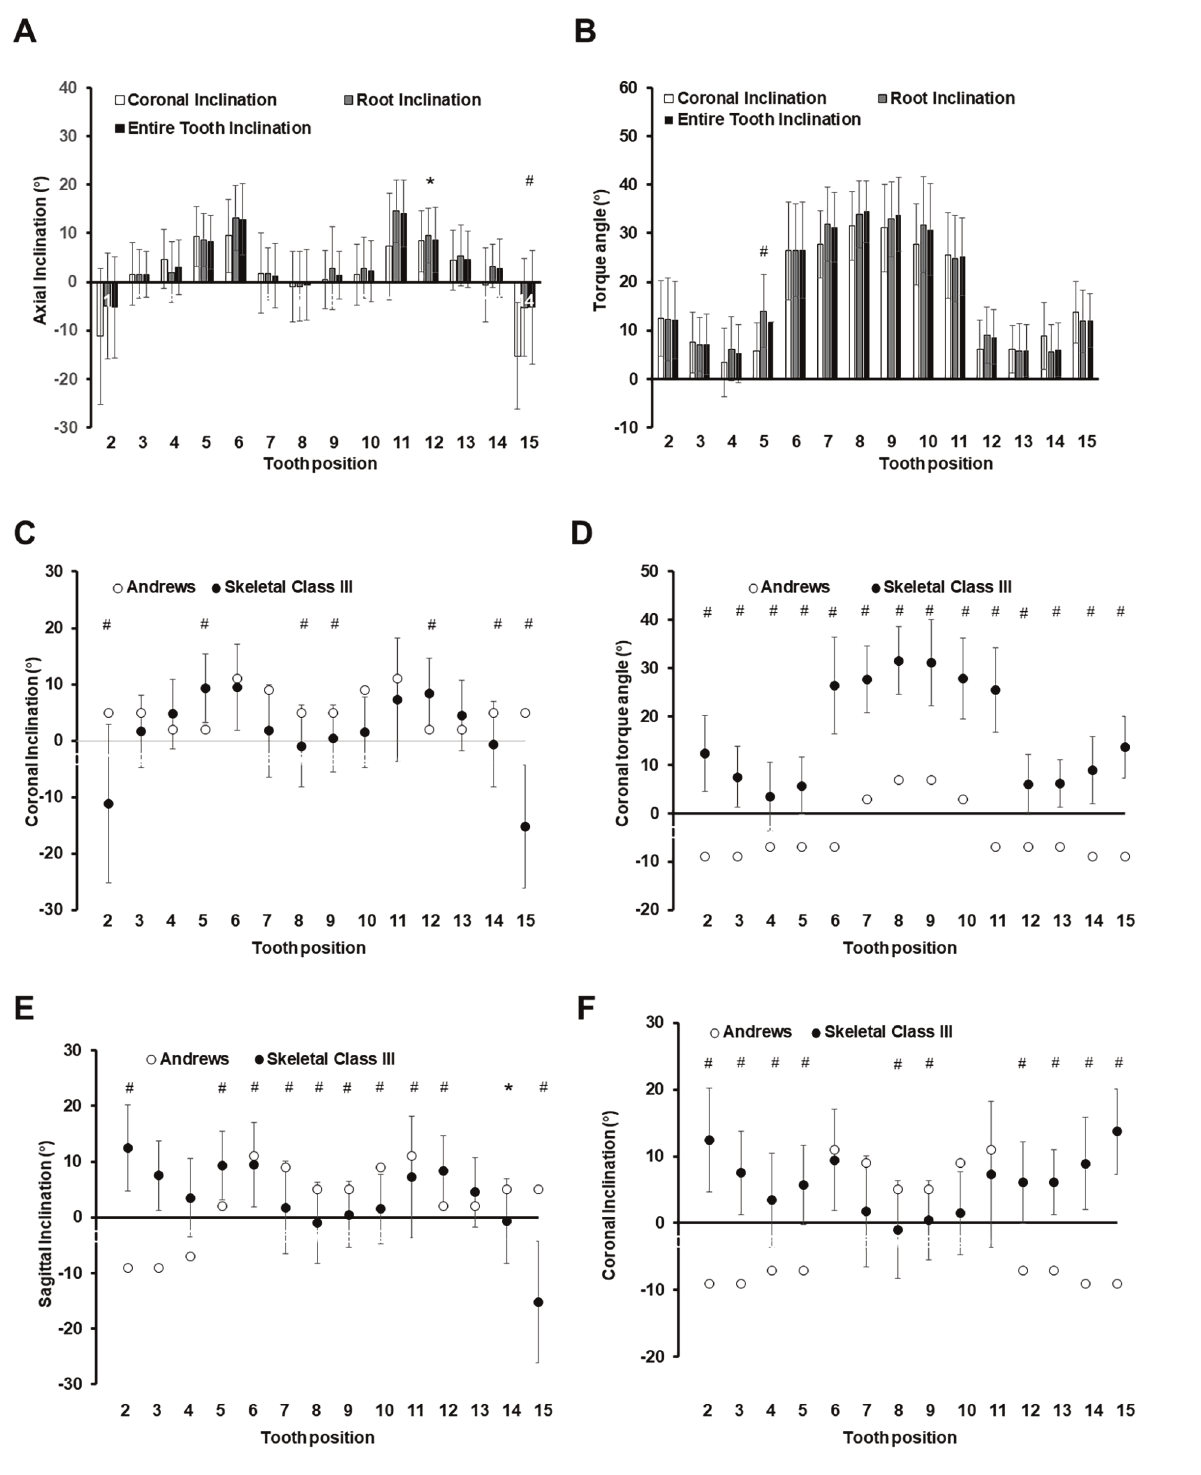
Figure 2: (A) Change in axial inclination of the maxillary tooth position for the skeletal class III malocclusion abnormality. (B) Change in torque angle of the maxillary tooth position for the skeletal class III malocclusion abnormality. (C) Comparison of the skeletal class III mal- occlusion with Andrew’s measurements for the maxillary coronal axial inclination. (D) Comparison of the skeletal class III malocclusion with Andrew’s measurements for the maxillary coronal torque angle. (E) Comparison between the skeletal class III malocclusion cases and the normal occlusion cases for sagittal inclination on the maxillary teeth. (F) Comparison between the skeletal class III malocclusion cases and the normal occlusion cases for the coronal inclination on the maxillary